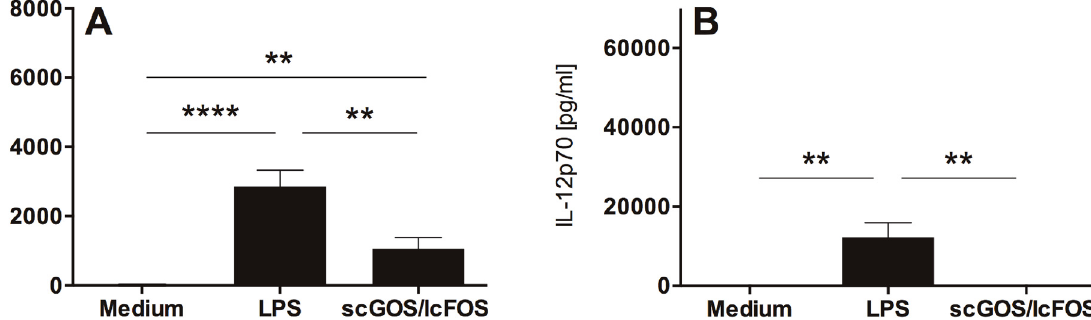
Fig 1. MoDC primed with scGOS/lcFOS are characterized by release of IL-10 while no IL-12p70 secretion is detectable. Immature human MoDC were incubated with scGOS/lcFOS (5 mg/ml) for 24h. Medium-treated MoDC served as negative control, MoDC matured by LPS as positive control for functional MoDC stimulation. Supernatants were analyzed for secretion of IL-10 (A) and IL-12p70 (B) by ELISA. Results are presented as mean ± SEM, ten independent experiments are shown. **** p < 0.0001, ** p < 0.01, unpaired student ’ s t test. scGOS/lcFOS = short chain galacto-, long chain fructo- oligosaccharides, MoDC = monocyte-derived dendritic cells.